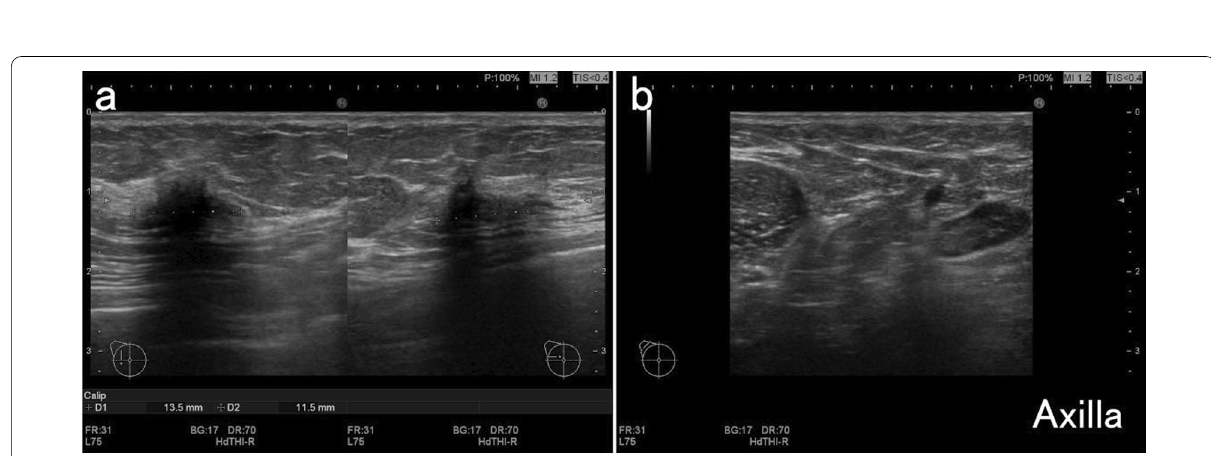
Fig. 2 Ultrasound findings of breast. a Irregular hypoechoic mass (13.5 mm) in right upper lateral zone. b Lymphadenopathy is not obvious in right